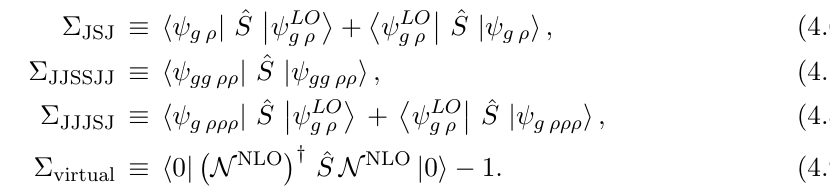
Figure 10 . (a) - The diagram for (cid:6) q (cid:22) q , (b) - The diagram for (cid:6) JSSJ . The black blub denotes the e(cid:11)ective emission vertex, which is de(cid:12)ned by j q (cid:22) q (cid:26) i . The e(cid:11)ective two gluon emission vertex corresponds to j gg (cid:26) i